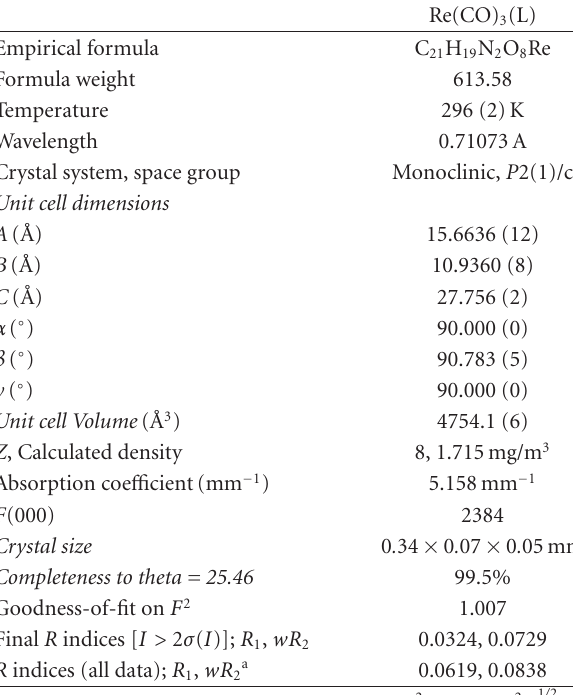
Table 1: Summary of crystal data of Re(CO) 3 (L). Table 2: Selected bond distances ( ˚A) and bond angles ( ◦ ) for the neutral complex: Re(CO) 3